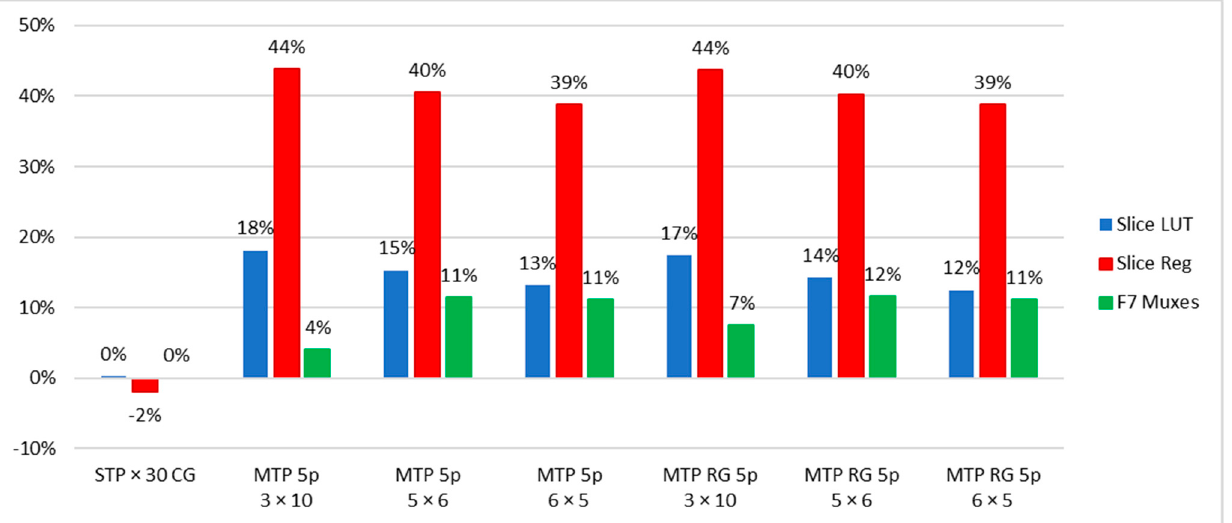
Figure 13. The comparison of resources savings relative to the architecture consisting of single-task cores (STP) for different structures with SP = 150.